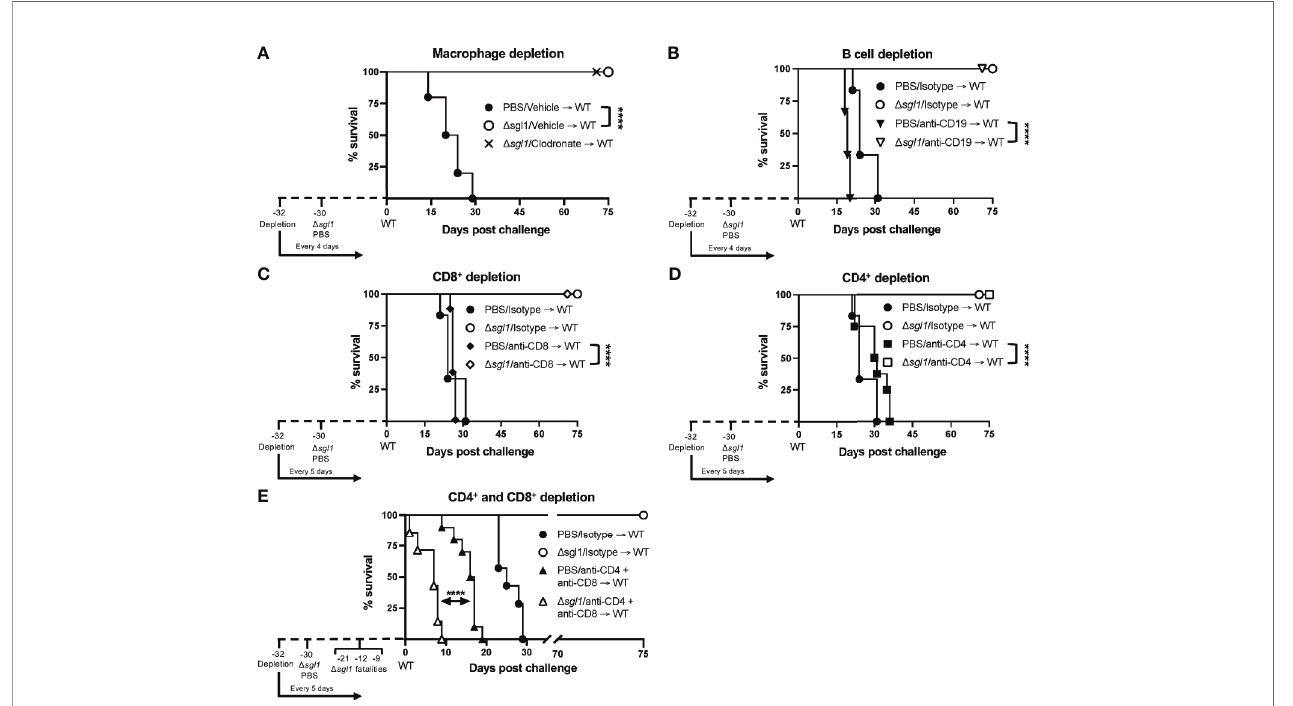
FIGURE 5 | Vaccination with C. neoformans (Cn) D sgl1 requires either CD4 + or CD8 + T cells for complete protection against lethal WT challenge. CBA/J mice (n=10 mice/group) were depleted of speci fi c cell types 48 hours prior to intranasal immunization with 5x10 5 Cn D sgl1 or PBS for unvaccinated controls, and depletions continued for the entirety of the experiment at set intervals. Mice were challenged with 5x10 5 WT strain 30 days post immunization and assessed for survival until day 75 post challenge. Mice administered PBS (unvaccinated controls) are denoted in black and Cn D sgl1 denoted in white. Signi fi cance was determnined by the Mantel-Cox log-rank test. Signi fi cance is denoted as **** P <